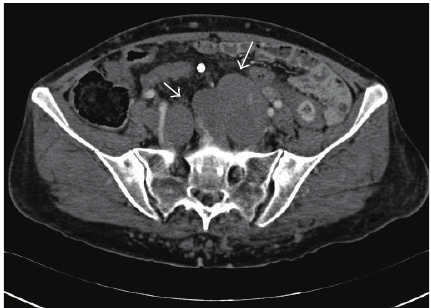
Figure 1: Axial contrast enhanced (arterial phase) CT of the pelvis demonstrating abnormal dilated lymphatic channels (arrows).